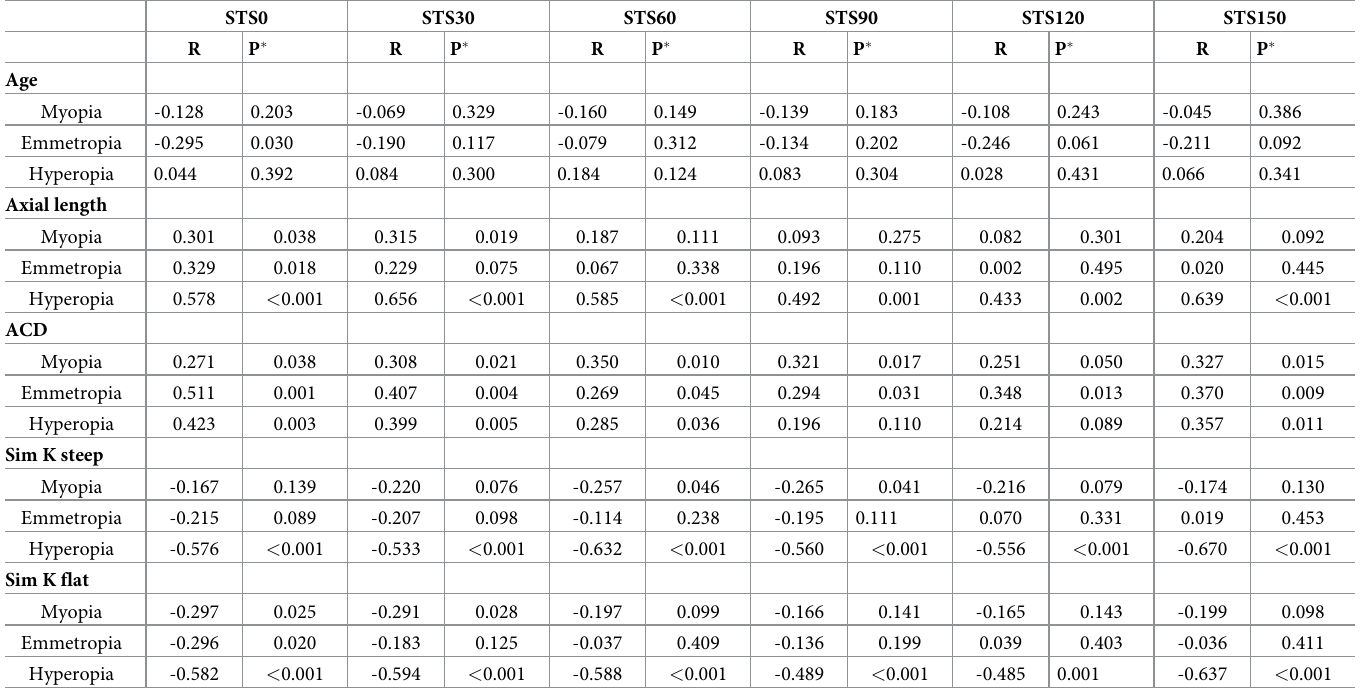
Table 5. Correlation between STS with age, axial length, anterior chamber depth, and Sim K at different meridians by refractive